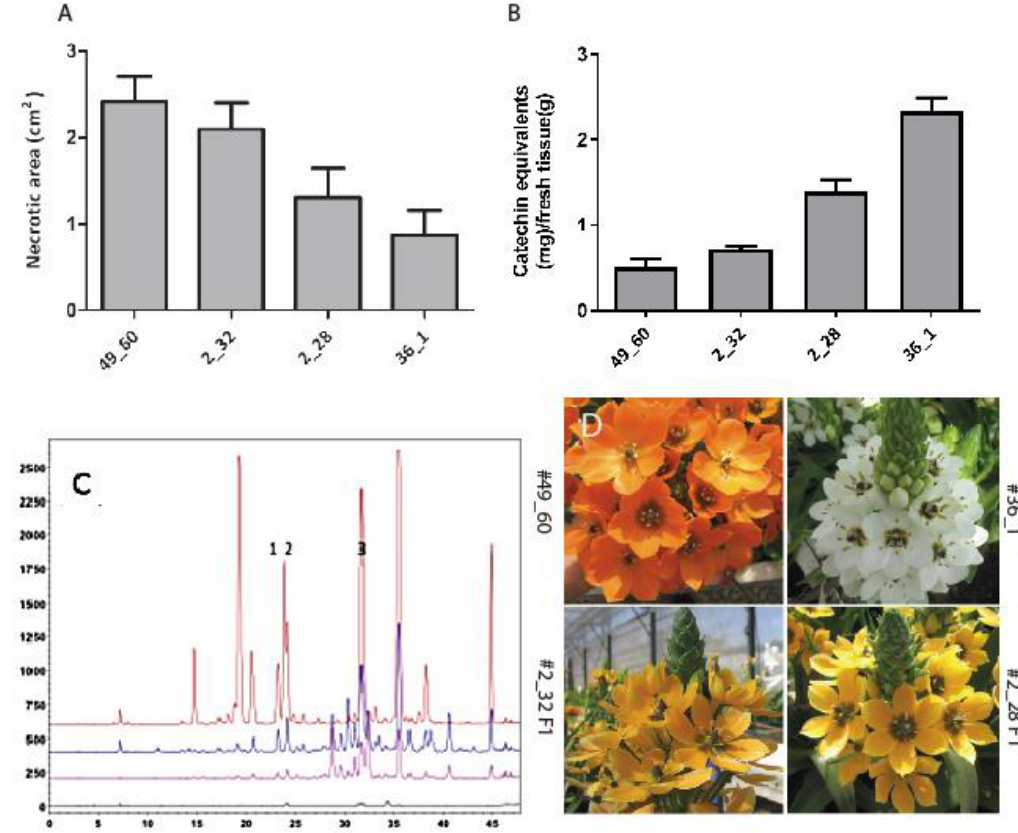
Figure 1. Characterization of Ornithogalum breeding lines: Disease development in Ornithogalum leaf discs (lines: #49_60, #36_1, #2_28 and #2_32) at 24 h after inoculation with 10 µ L of Pectobacterium carotovorum suspension (10 8 CFU / mL). ( A ) Disease severity is expressed as total necrotic area. ( B ) Levels of polyphenolic compounds in methanolic extracts of Ornithogalum lines, expressed as catechin equivalents (mg / g fresh tissue). ( C ) RP-LC-UV chromatograms, at 336 nm, of extracts from all Ornithogalum lines: Clones #49_60 (black), #2_32 (pink), #2_28 (blue) and #36_1 (brown). ( D ) Flowering of the parental lines and F1 hybrids of the Ornithogalum that were used in the study.